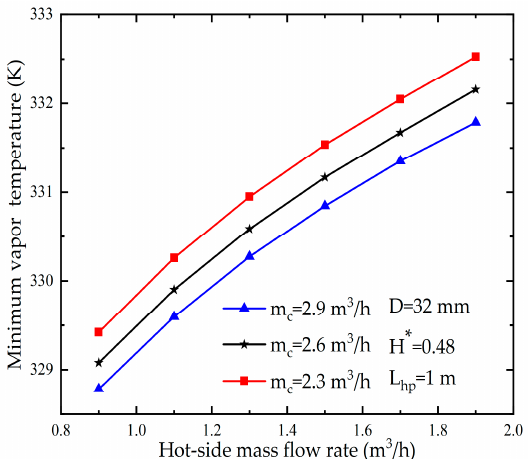
Figure 7. Comparison of minimum vapor temperature with different cold side mass flow rates.